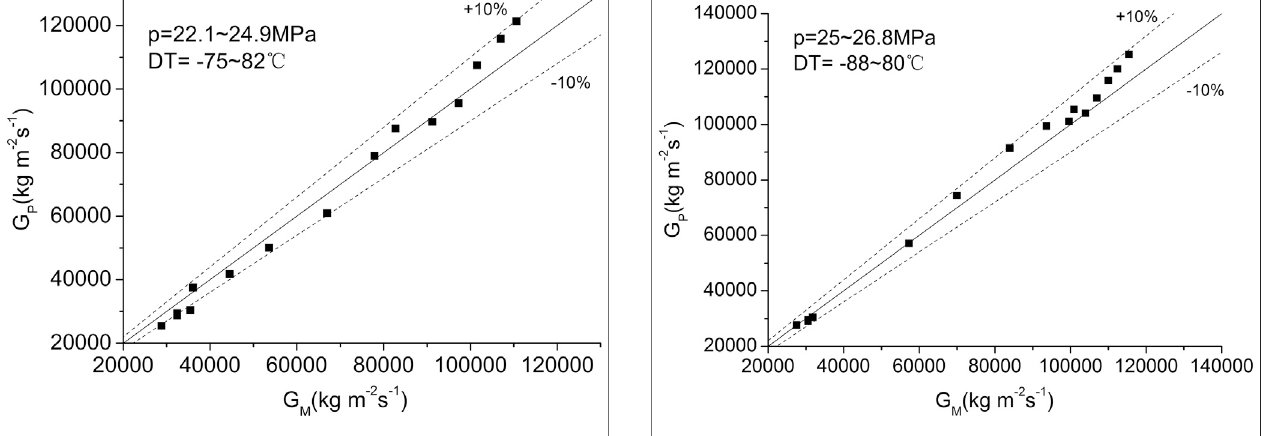
FIGURE 3 | Comparison to the result of Chen ( p (cid:1) 22.1 – 24.9 MPa). FIGURE 4 | Comparison to the result of Chen ( p (cid:1) 25 – 26.8 MPa).